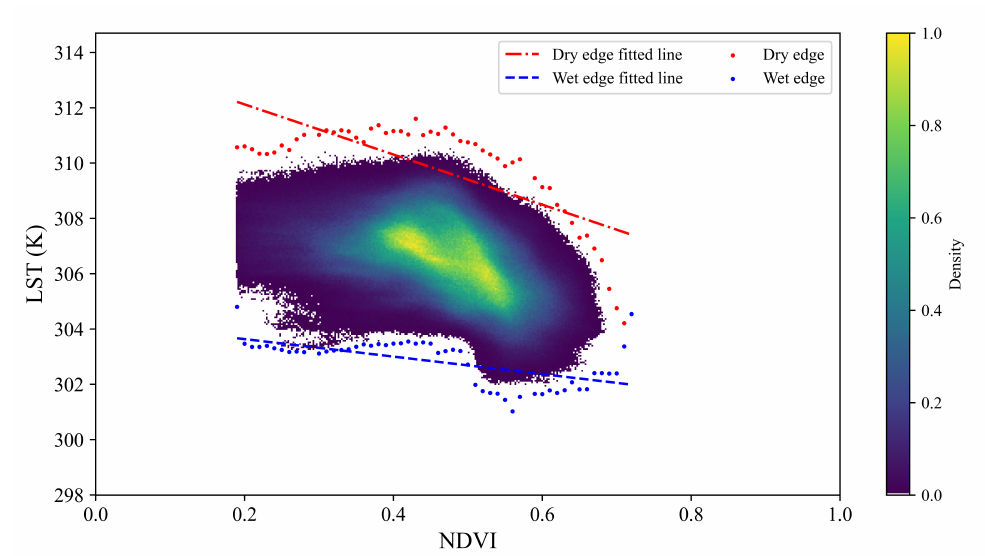
Figure 9. Dry/wet edges and their fitting equations derived from density scatterplots of NDVI and downscaled